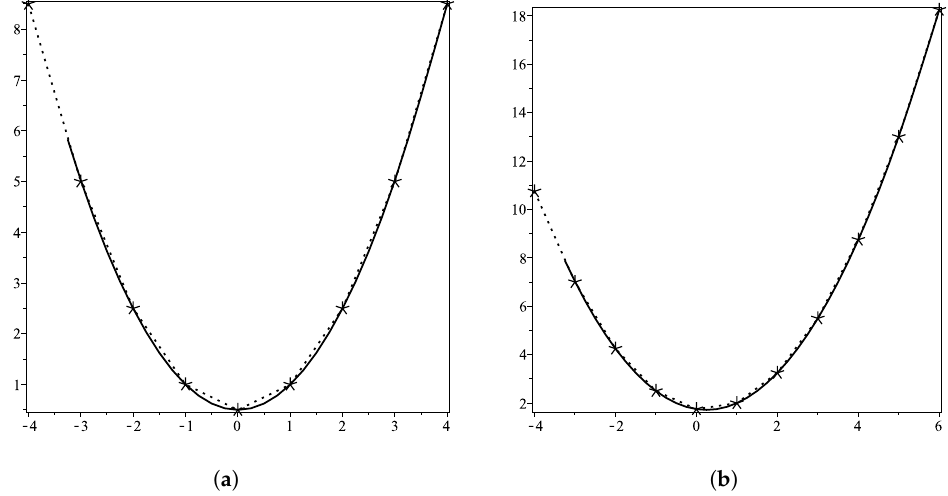
Figure 3. ( a , b ) show convex curve generated by FP -scheme (1) using convex initial